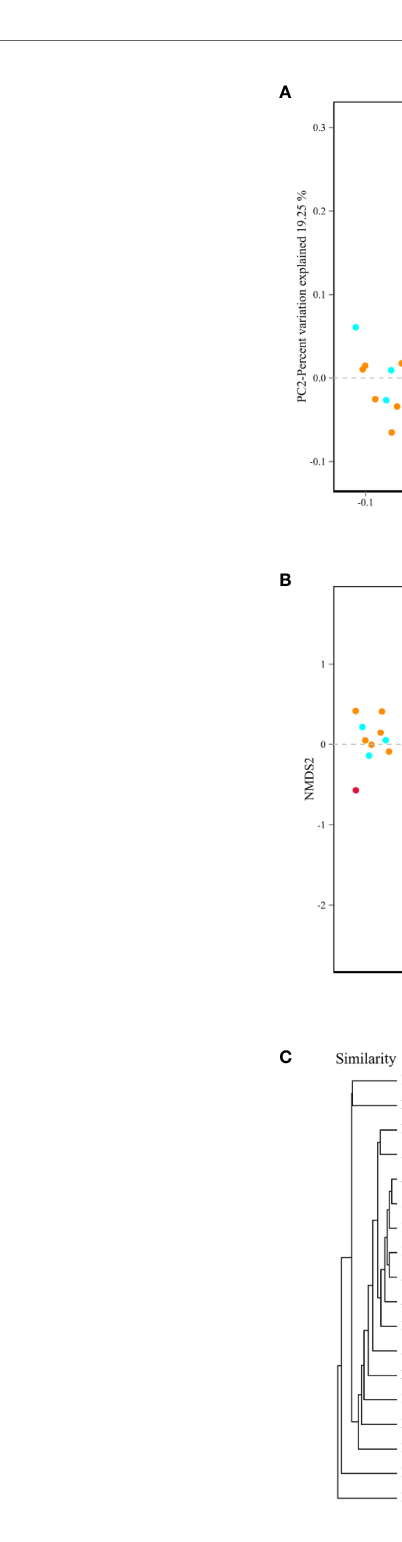
FIGURE 2 | Beta diversity of intestinal microbiota based on genus level. (A) Principal Coordinate Analysis (PCoA) against PC1 vs PC2 axes; (B) Non-Metric Multi- Dimensional Scaling (NMDS) against NMDS1 vs NMDS2 axes; (C) UPGMA clustering trees. F1, F2, F3, F4, F5 and F6 are the six replicates of group C; B1, B2, B3, B4, B5 and B6 are the six replicates of the group LF3; A1, A2, A3, A4, A5 and A6 are the six replicates of the group